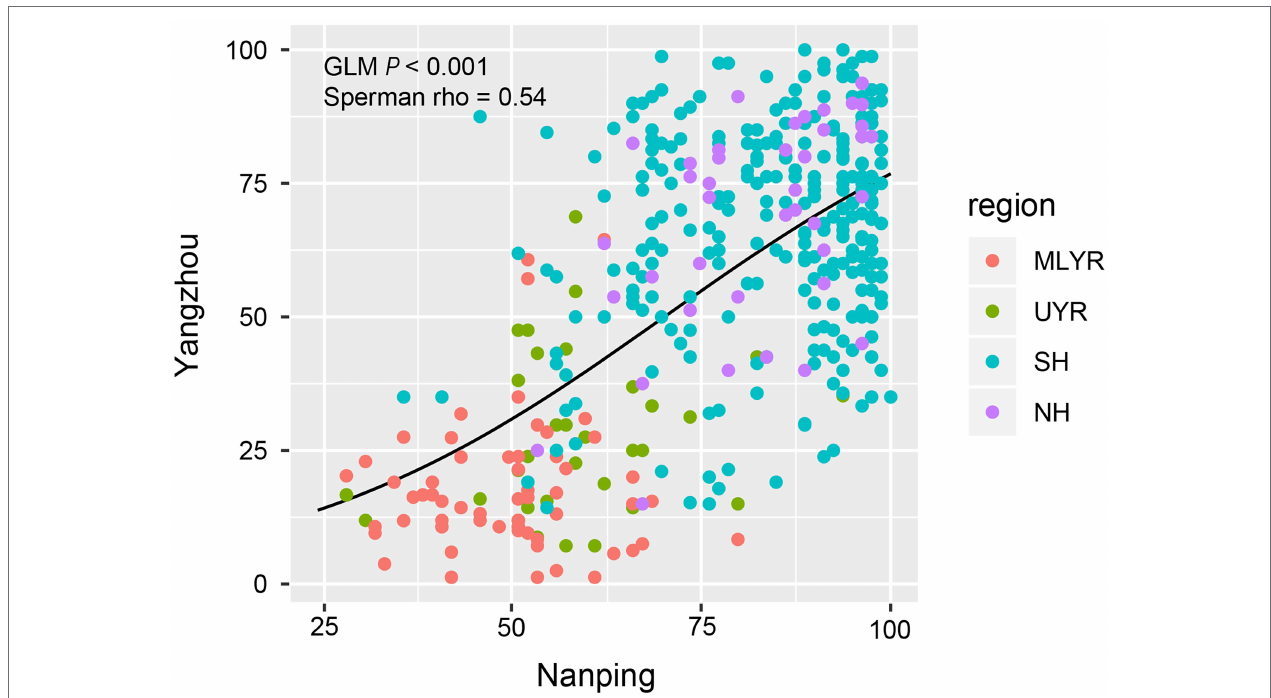
FIGURE 4 | The correlation of Fusarium Head Blight DIs for 410 cultivars between the nurseries in Nanping and Yangzhou (x and y axes represent the DI value). The cultivars from MLYR showed low DIs in both locations, followed by the cultivars from UYR. The majority of cultivars from both SH and NH showed higher DIs at both nurseries. Removal of those cultivars showing DIs > 90 improved the correlation from rho = 0.54–0.64.